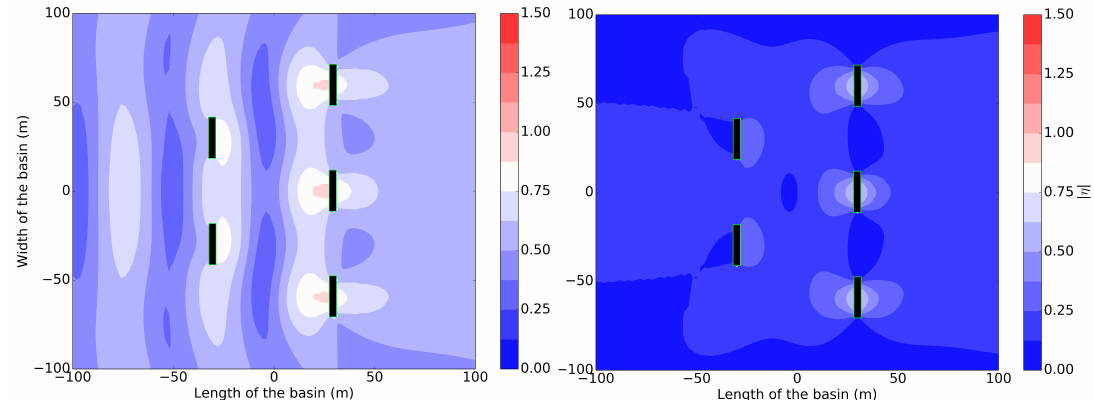
Figure 19. The total ( left ) and perturbed ( right ) | η | for an OSWEC for a wave of H = 1.0 m, T = 10.0 s for a linear PTO system. Incident wave propagating from the left.